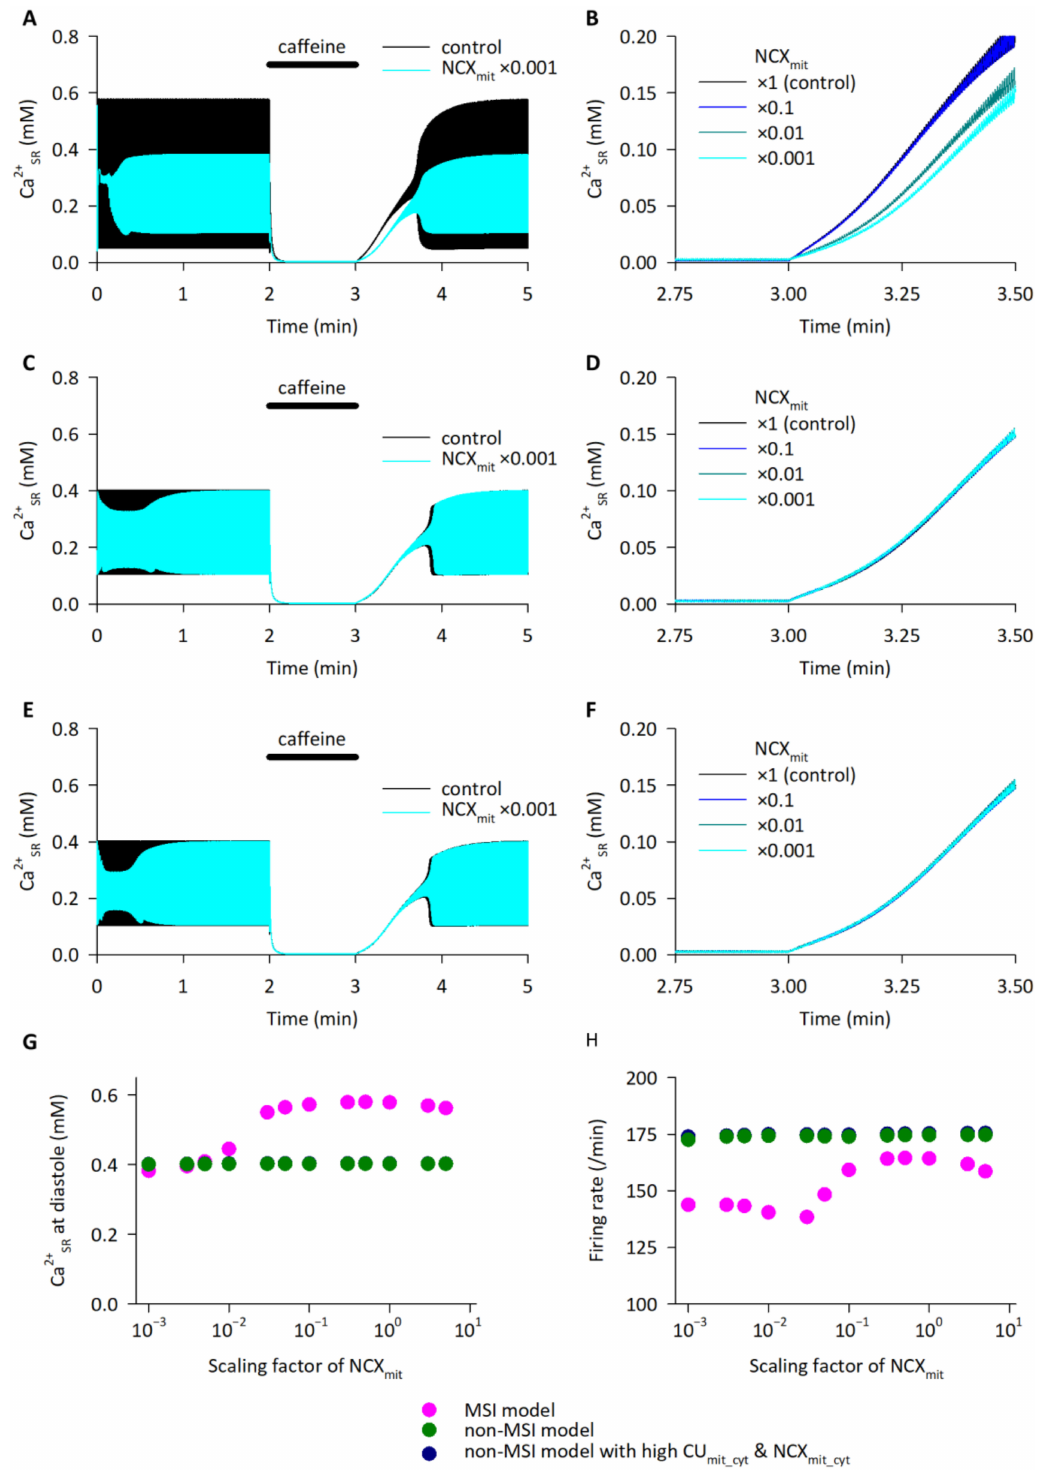
Figure 9. Model simulations of caffeine application and removal. ( A ) Time courses of SR Ca 2+ concentrations obtained by using MSI model. Black and light blue lines represent simulated data with control and reduced scaling factor to × 0.001 of NCX mit at time 0, respectively. ( B ) Same protocol was applied to the MSI model with various scaling factors of NCX mit , × 1 (control), × 0.1, × 0.01, and × 0.001. SR Ca 2+ reuptake phase is magnified. ( C ) Time courses of SR Ca 2+ concentrations obtained by using non-MSI model. Black and light blue lines represent simulated data with control and reduced scaling factor to × 0.001 of NCX mit at time 0, respectively. ( D ) Same protocol was applied to the